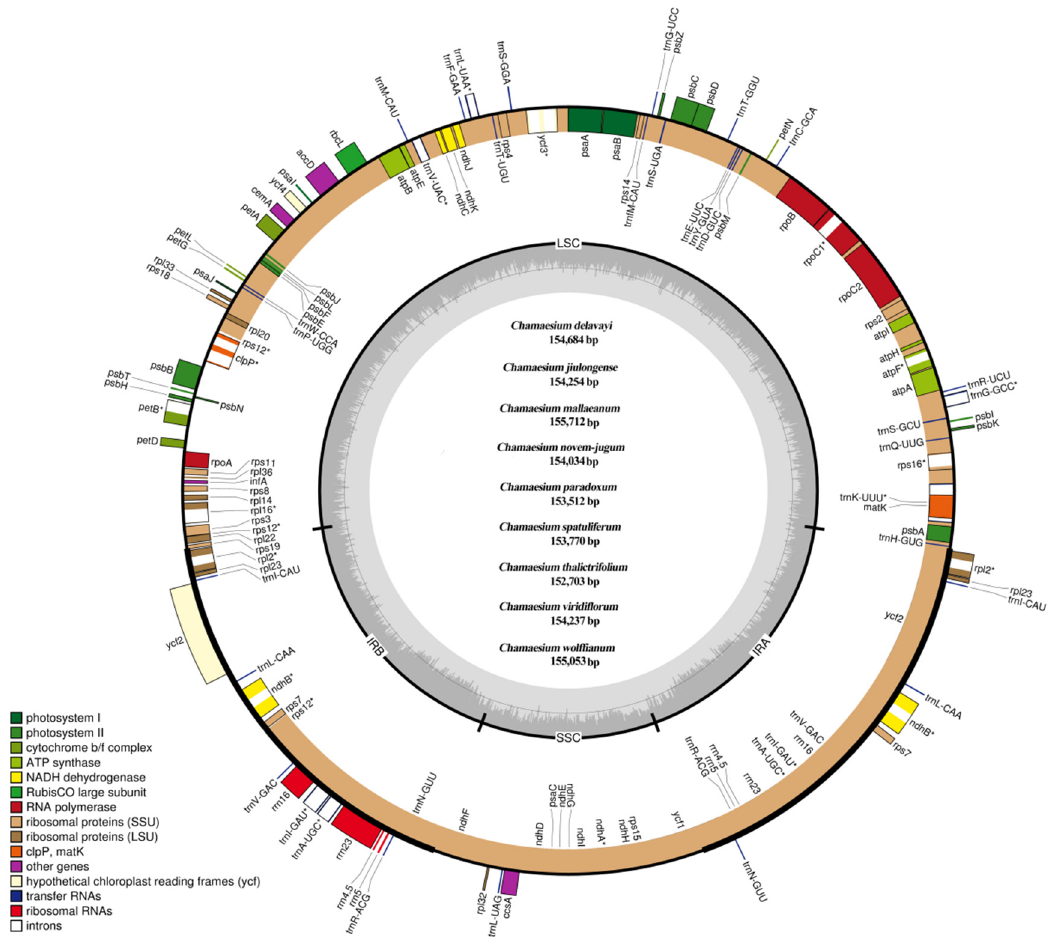
Figure 2. Plastid genome map of Chamaesium . The genes shown inside and outside of the circle are transcribed in the clockwise and counterclockwise directions, respectively. Genes belonging to different functional groups are drawn in different colors. The darker grey area in the inner circle indicates the GC content, while the lighter grey corresponds to the AT content. LSC, large single copy; SSC, small single copy; IR, inverted